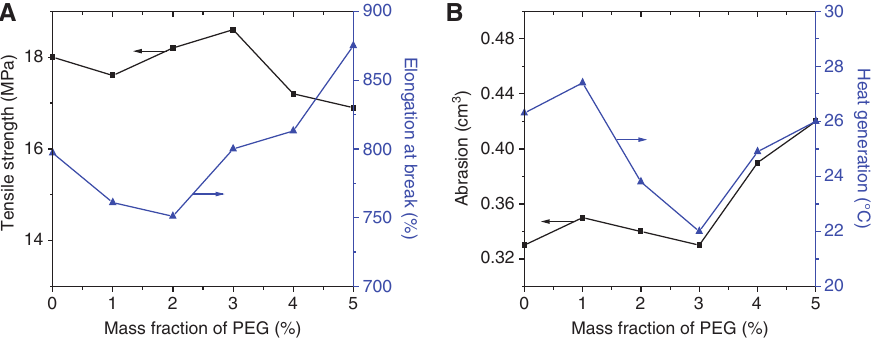
Figure 5 Mass fraction of PEG on the mechanical properties of the zeolite/rubber composites. (A) Tensile strength and elongation at break of composites; (B) abrasion property and dynamic heat generation of